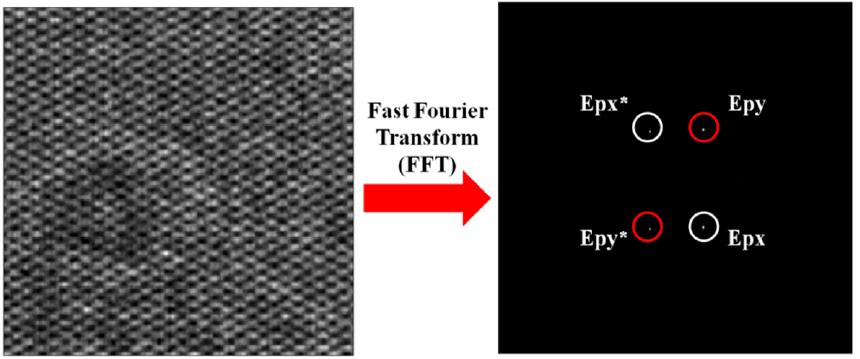
Figure 4. Recorded interferogram and corresponding Fourier spectrum at grayscale 255 of the SLM +45° polarized input light. Asterisk (*) represents the conjugate of the corresponding field.